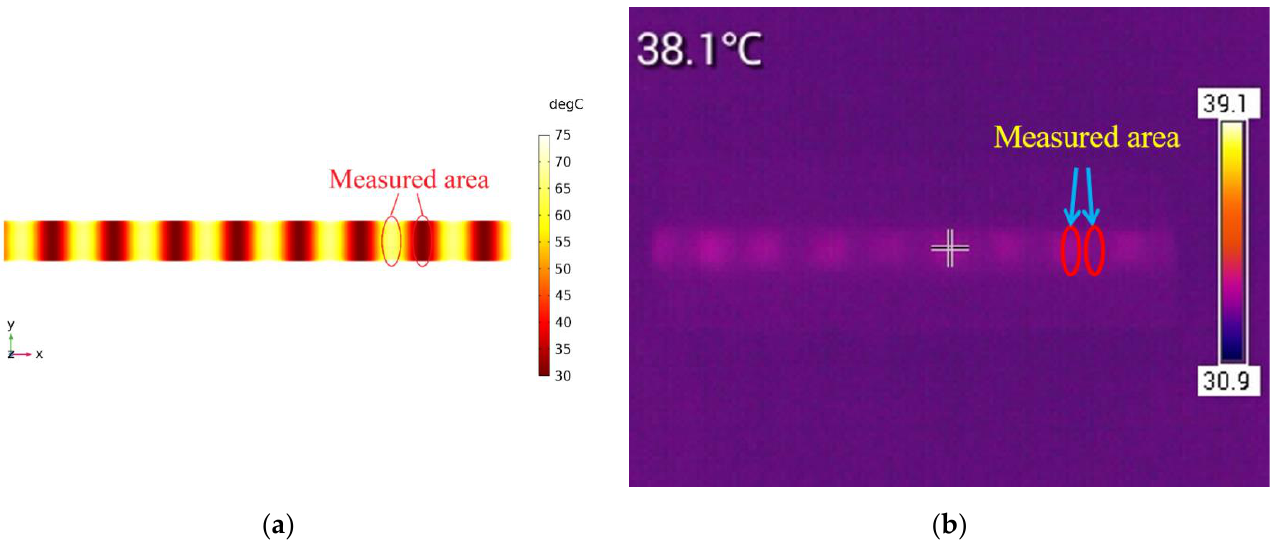
Figure 9. The temperature distribution of the film in the x – y plane. ( a ) Simulation; ( b ) Experiment.